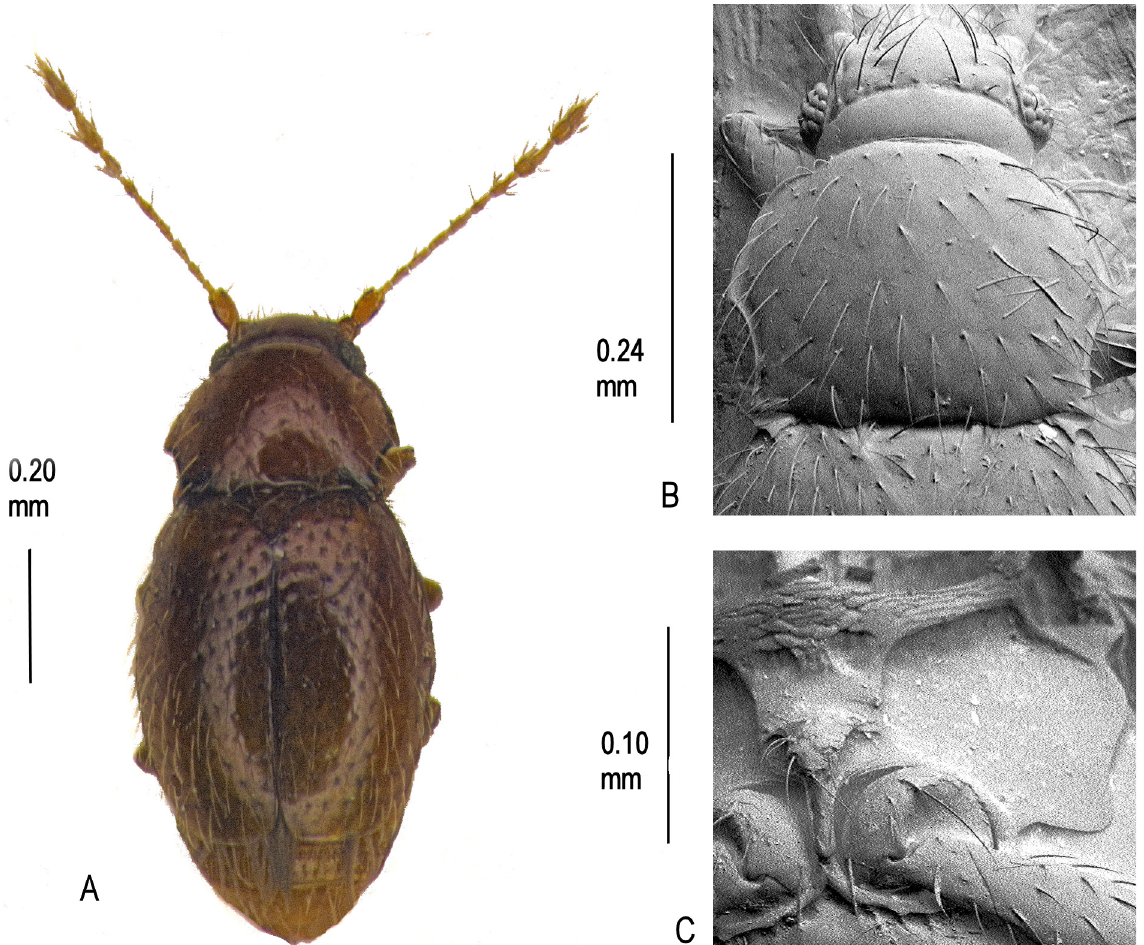
Fig. 99 . Cissidium orami sp. nov. A . Habitus. B . Pronotum, × 550. C . Mesoventrite showing median process of collar, mid-keel and keel,